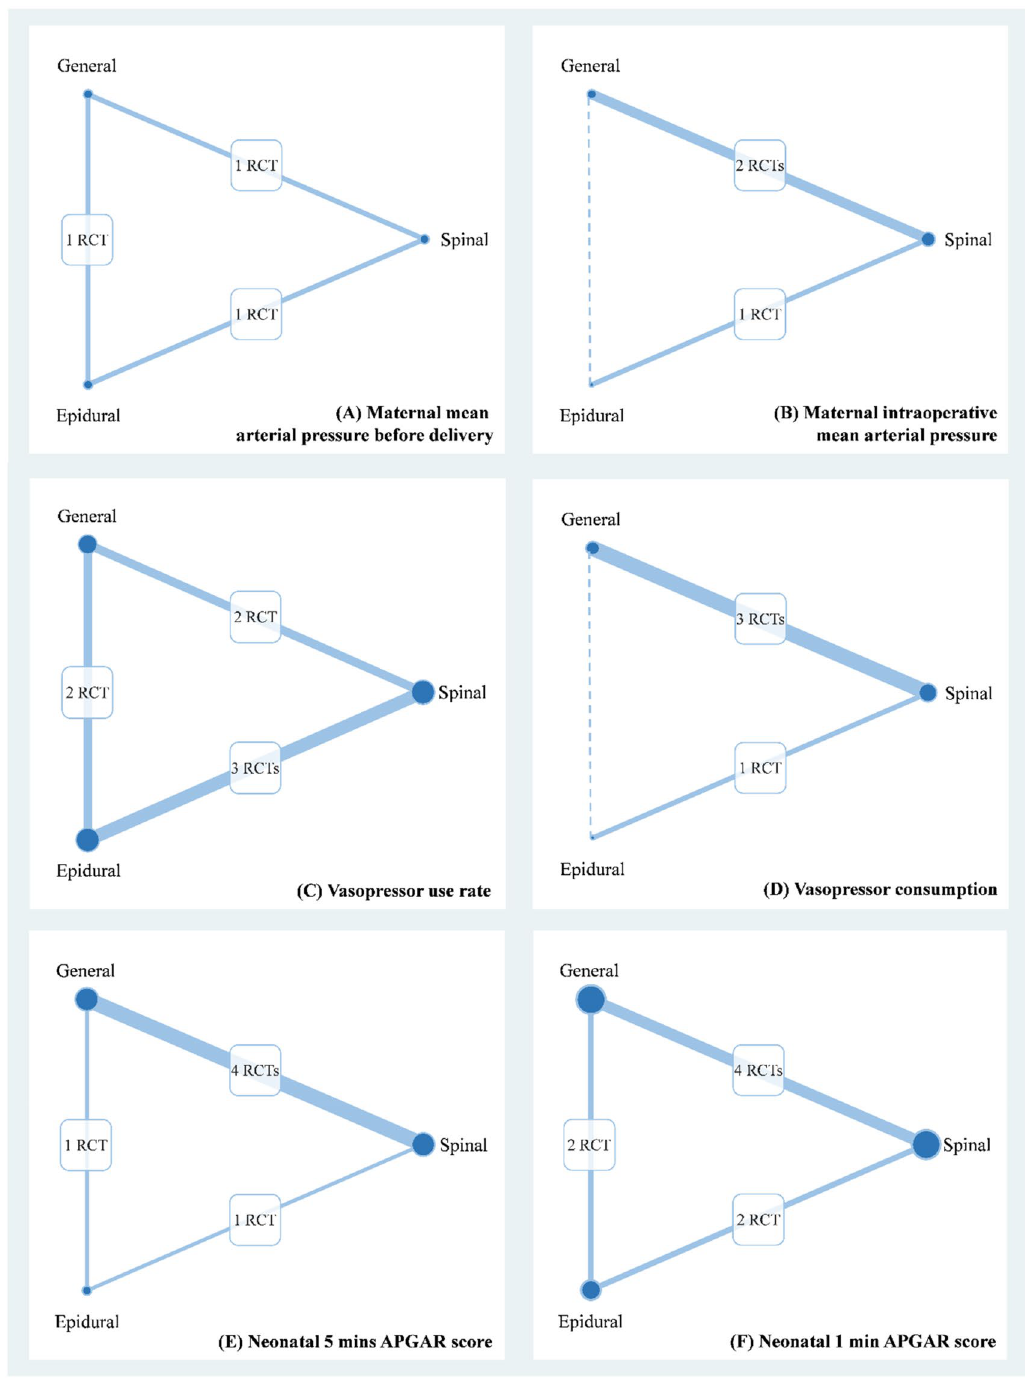
neonatal 5 min APGAR score, and ( F ) neonatal 1 min APGAR